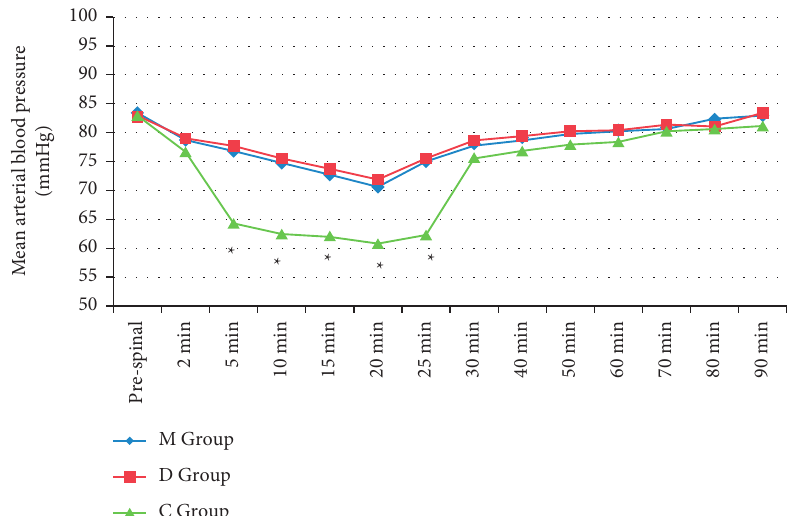
Figure 3: Mean arterial blood pressure (mm · Hg) changes over 90 minutes among the studied groups. ∗ Statistically significant.